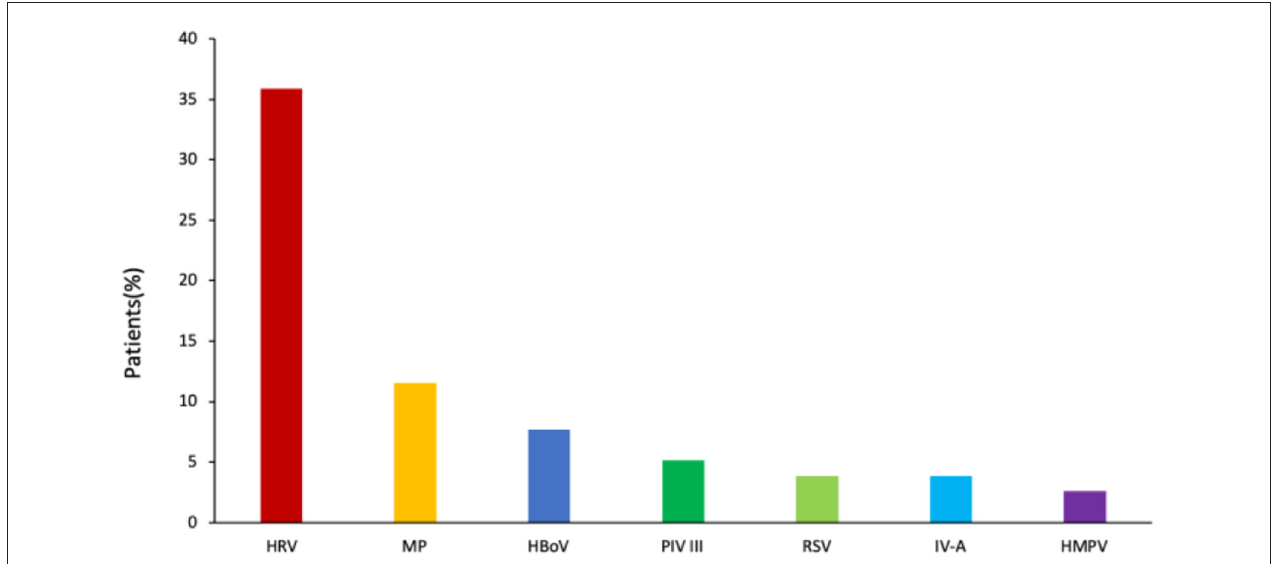
FIGURE 3 | Distribution of pathogen coinfections associated with B. pertussis infection.